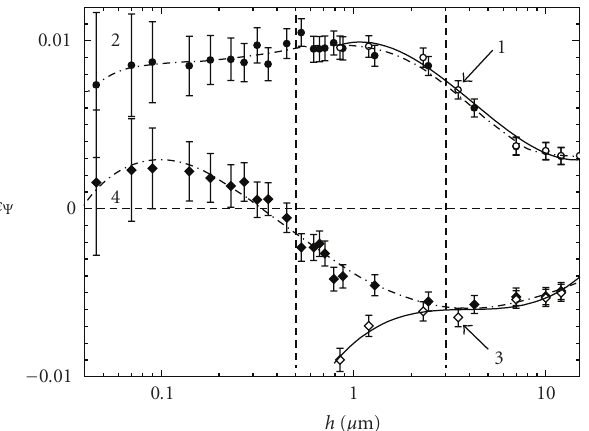
Figure 6: Components of the microstrain in the B2 phase lattice in relation to the penetration depth in the TiNi specimens irradiated with E 1 = 4J/cm 2 : ε Ψ = 90 ◦ = 90 (1, 2) and ε Ψ = 0 (3, 4). Curves 1 ( ◦ ), 3 ( ♦ )—immediately after irradiations, curves 2 ( • ), 4 ( (cid:3) )—a year later.